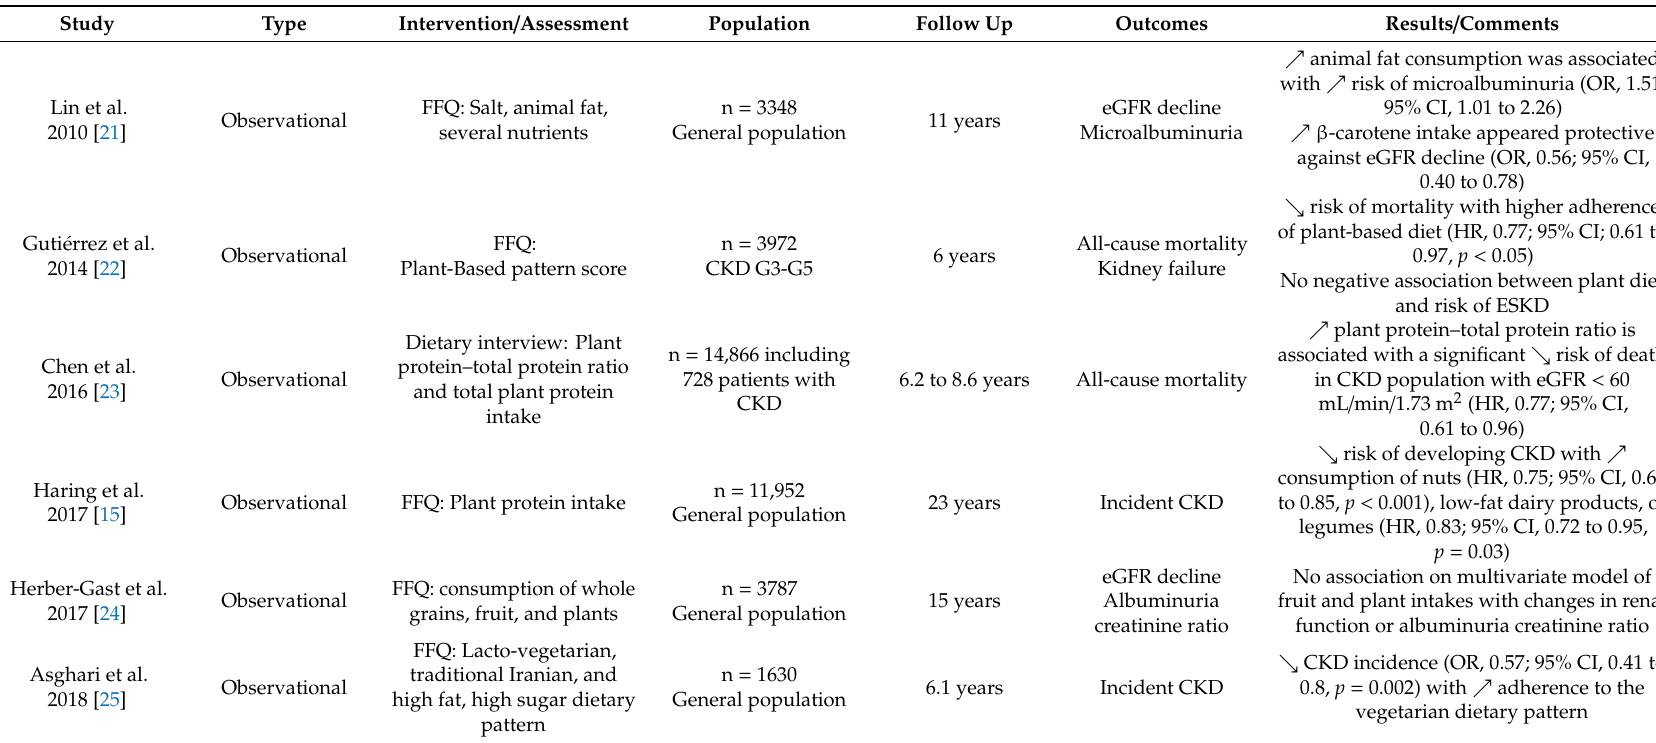
Table 1. Observational studies analyzing plant protein or plant-based dietary pattern and chronic kidney disease (CKD) incidence or